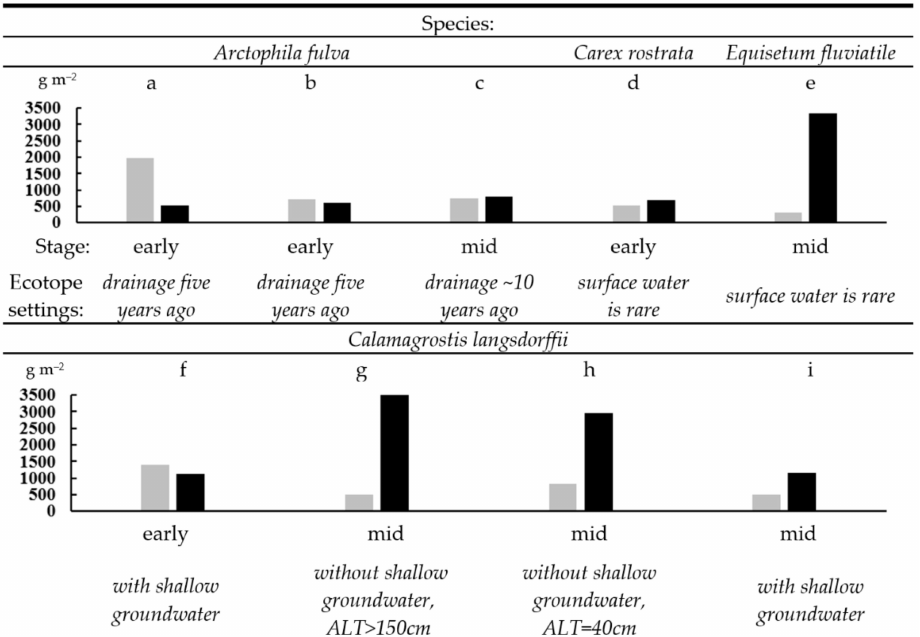
Figure 10. The ratio of aboveground (grey) and underground (black) phytomass (g · m − 2 ). The meadows dominated by: ( a – c )— Arctophila fulva (sites tz18–28, tz18–47, and tz18–24, respectively); ( d )— Carex rostrata (tz18–46); ( e )— Equisetum fluviatile (tz18–51); ( f – i )— Calamagrostis langsdor ffi i (tz18–27, tz18–50, tz18–52, and tz18–53,